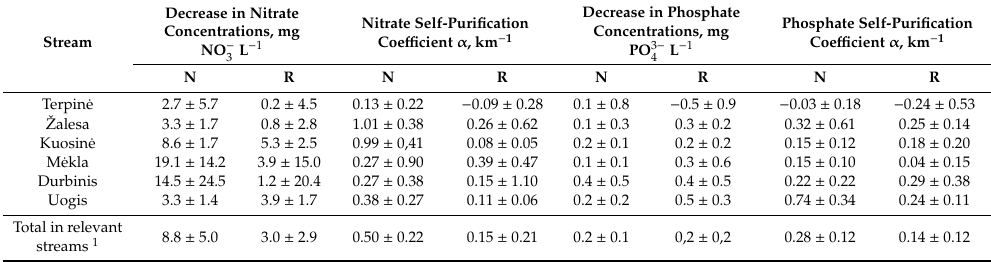
Table 4. Average decrease in nitrate and phosphate concentrations in natural and regulated stream stretches and self-purification coe ffi cients (R-regulated stretch, N-natural stretch).